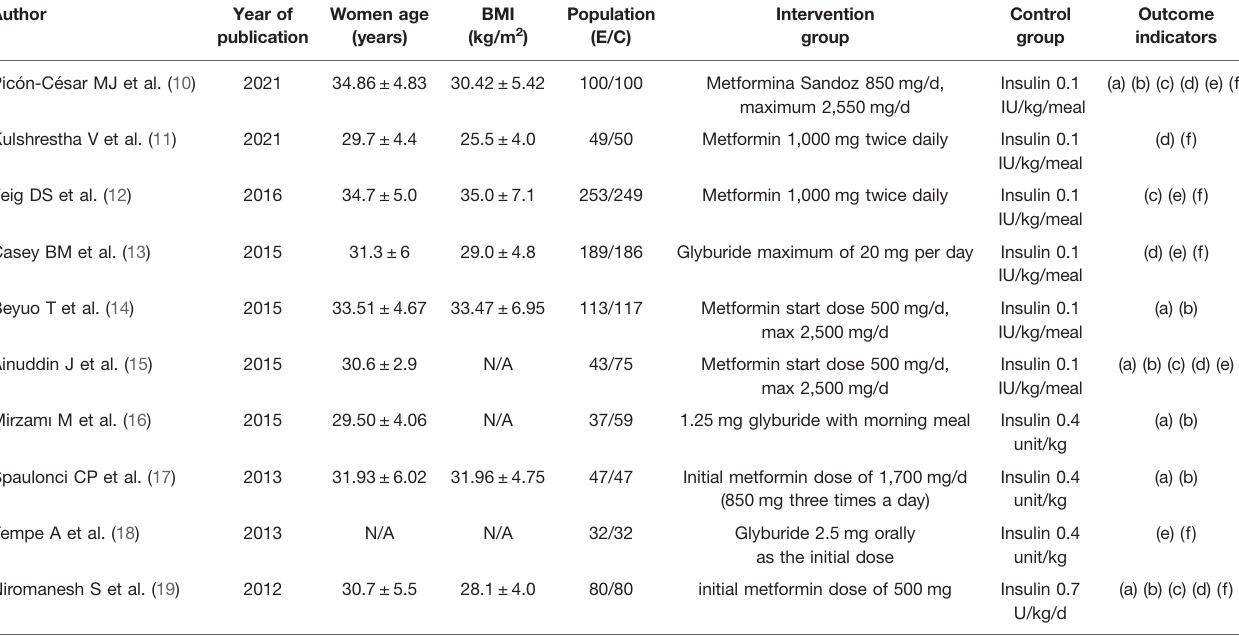
Abbreviation: E indicates the intervention group and C indicates the control group . Outcomes: ( a ) Fasting blood glucose; ( b ) Postprandial glycemia after lunch; ( c ) HbA1c; ( d ) Maternal weight gain; ( e ) Abortion rate; ( f ) Cesarean section rate .